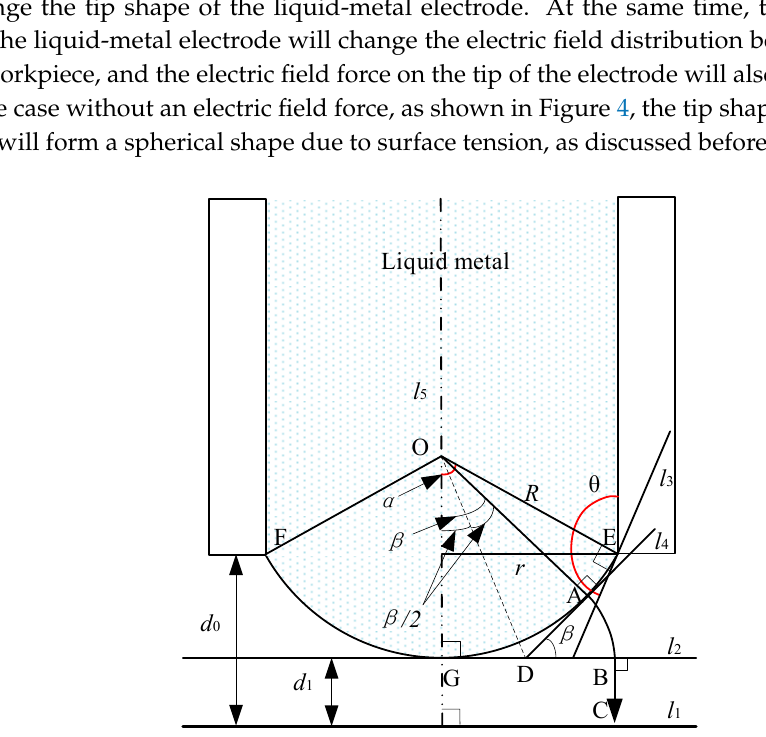
Figure 3. Pressures of the liquid-metal electrode on the nozzle tip.